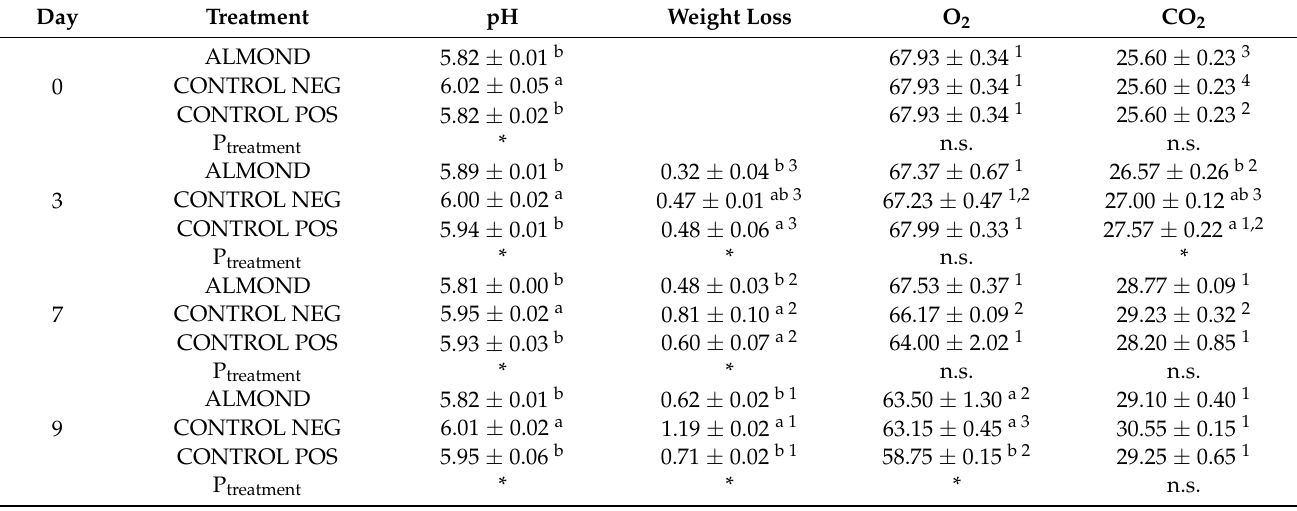
Table 3. Evolution of oxygen (%) and carbon dioxide (%) content in headspace, pH and weight loss (%) of packs of pork patties of different treatments stored in MAP for 9 days. Values are reported as mean ± SD (n =